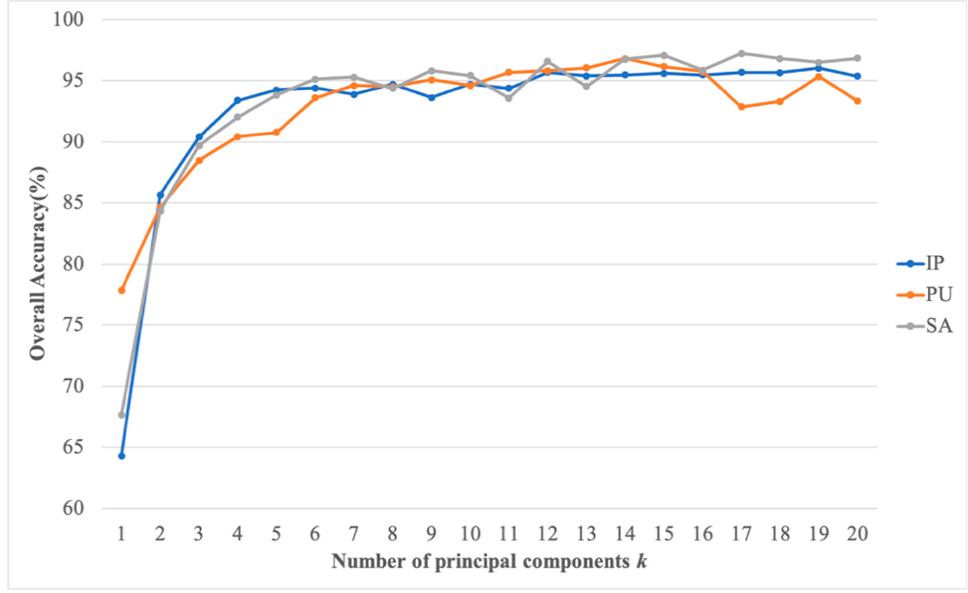
Figure 7. OA of the MSPN using different numbers of principal components k .